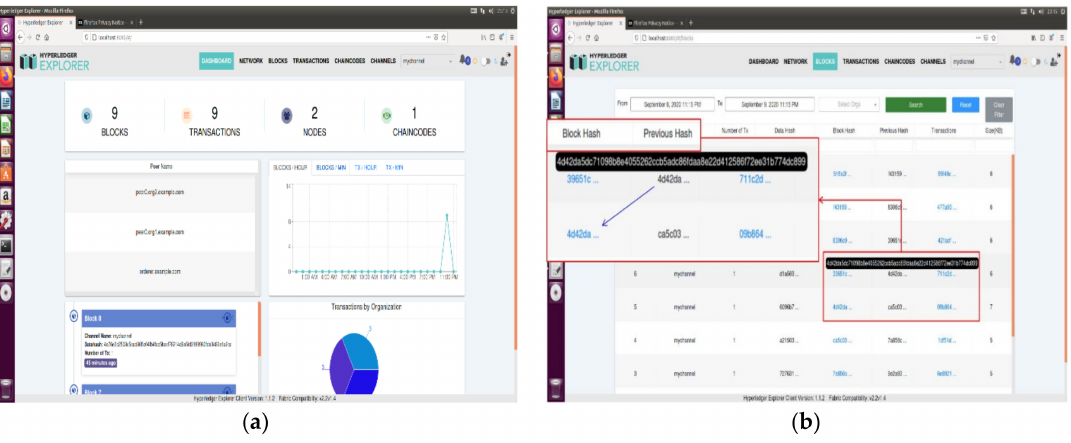
Figure 10. The page views of HyperLedger explorer. ( a ) main page; ( b ) blocks